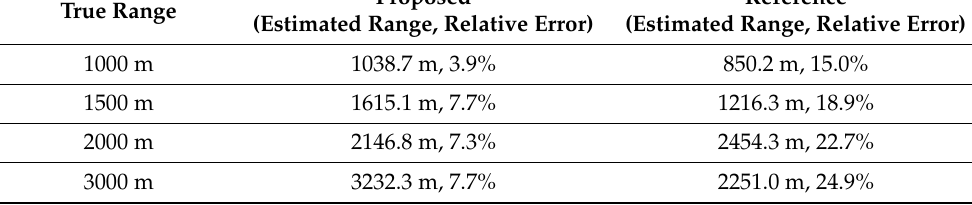
Table 1. The range estimates and relative errors of the proposed and reference methods at different ranges in the simulation.